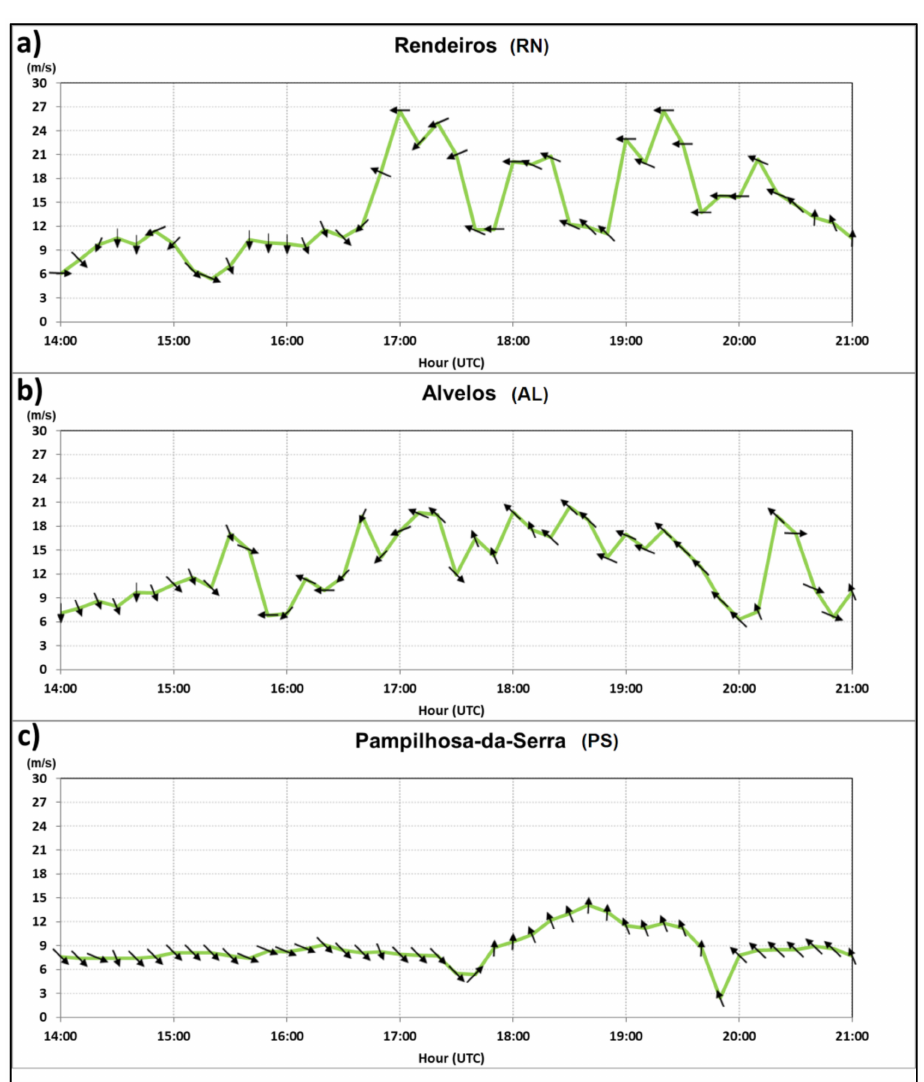
Figure 15. Wind gusts magnitude (green line), average wind direction (arrows) at ( a ) Rendeiros (PE RN) windmill Park, ( b ) Alvelos (PE AL) Windmill Park and ( c ) Pampilhosa da Serra (PE PS) Windmill Park. Observations at 60–80 m a.g.l., 14:00–21:00 UTC, 17 June